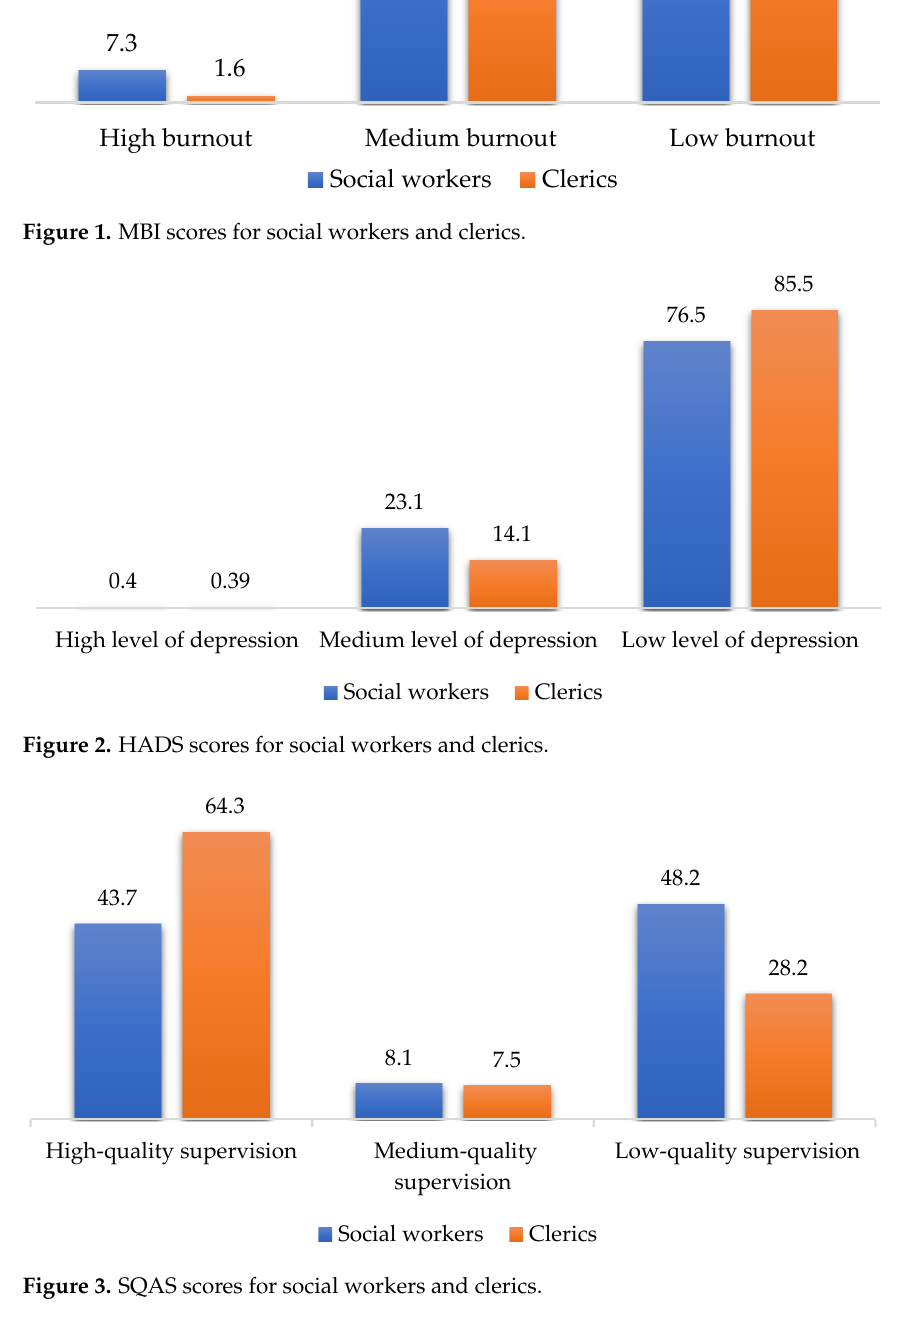
Figure 4. RSS scores for social workers and clerics. According to these results, there are statistically significant differences between cler- ics and social workers (chi square = 15.121, df = 2, p < 0.001), in the sense that social workers recorded higher burnout scores than clerics (MBI). Additionally, the level of depressive symptoms (HADS) is 9% higher among social workers than clerics (the differences being not statistically significant). Regarding supervision (SQAS), there were statistically signif- icant differences (chi square = 22.999, df = 2, p < 0.001) in the sense that clerics recorded significantly higher scores (above 20%) compared to social workers in quality of supervi- sion. A completely different situation between the two sub-samples was obtained in the level of spirituality, the clerics having, as expected, a 40% higher level of spirituality than social workers (chi square = 39.374, df = 2, p < 0.001). The comparative analysis through the median and percentiles 25–75 between the scores obtained by the two subgroups (so- cial workers and clerics) in the four scales reflects a clear differentiation (Table 2).